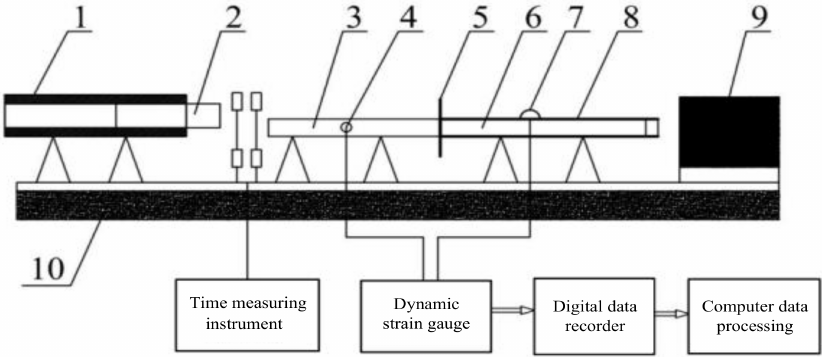
Figure 3. Schematic diagram of the High Split Hopkinson Pressure Bar (SHPB) device. It contains ten major components: (1) Gas gun; (2) Impact bar; (3) Input bar; (4, 7) Strain gauge; (5) Specimen; (6) Absorbing bar; (8) Output bar; (9) Waveform storage device; (10) Support